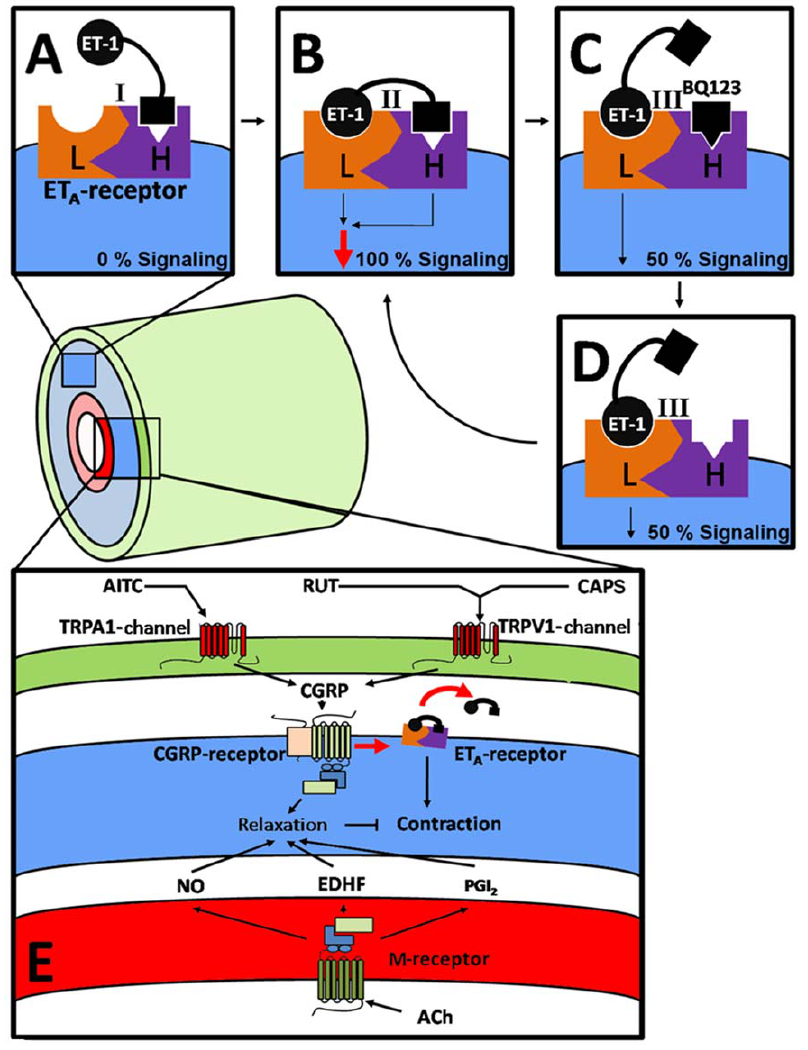
Figure 7. Schemes illustrating the interaction of ET-1 with arterial smooth muscle ET A -receptors (A – D) and the influences of vasodilators. A, Initially, a part of ET-1 binds to a high affinity binding site (H) on an ET A -receptor. B, next, another part of ET-1 binds to a low affinity binding site (L) of the receptor. Signaling is triggered by the occupied site L and reinforced by the occupied site H. C, while binding of ET-1 to site L is quasi-irreversible, the binding of ET-1 to site H remains dynamic and can be competed off by low molecular weight antagonists such as BQ123.